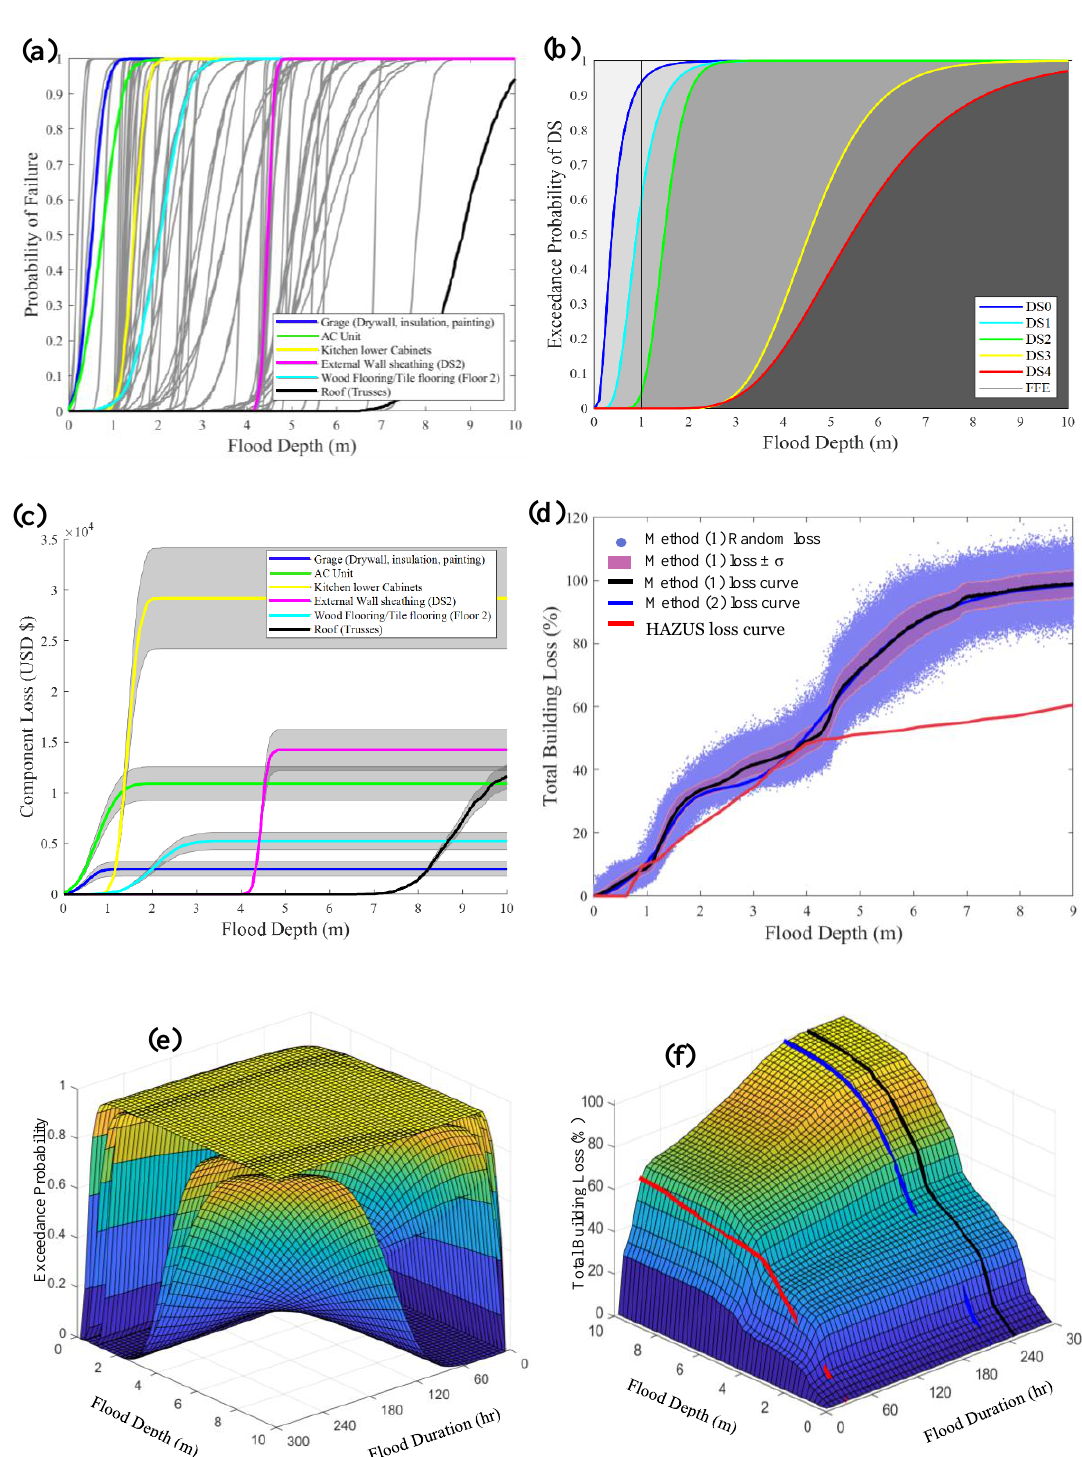
Figure A17. F3 archetype analysis results: ( a ) Component fragility curves; ( b ) Building fragility curves; ( c ) Selected components’ loss curves; ( d ) Building loss curves; ( e ) Building fragility surfaces; ( f ) Building loss surface.